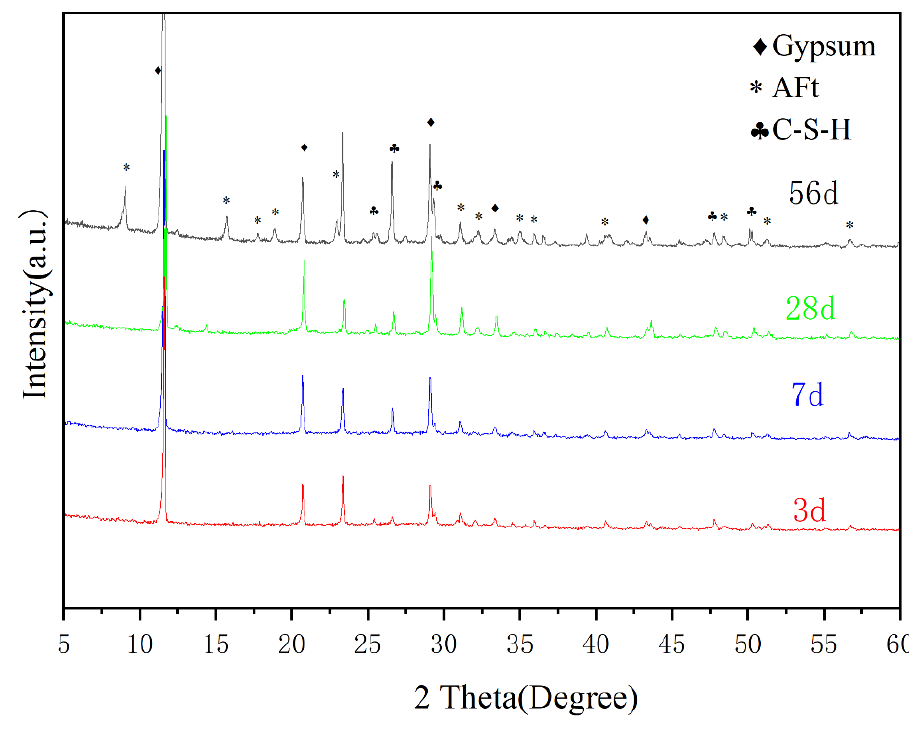
Figure 4. XRD patterns of hydration products of No.2 at different ages.